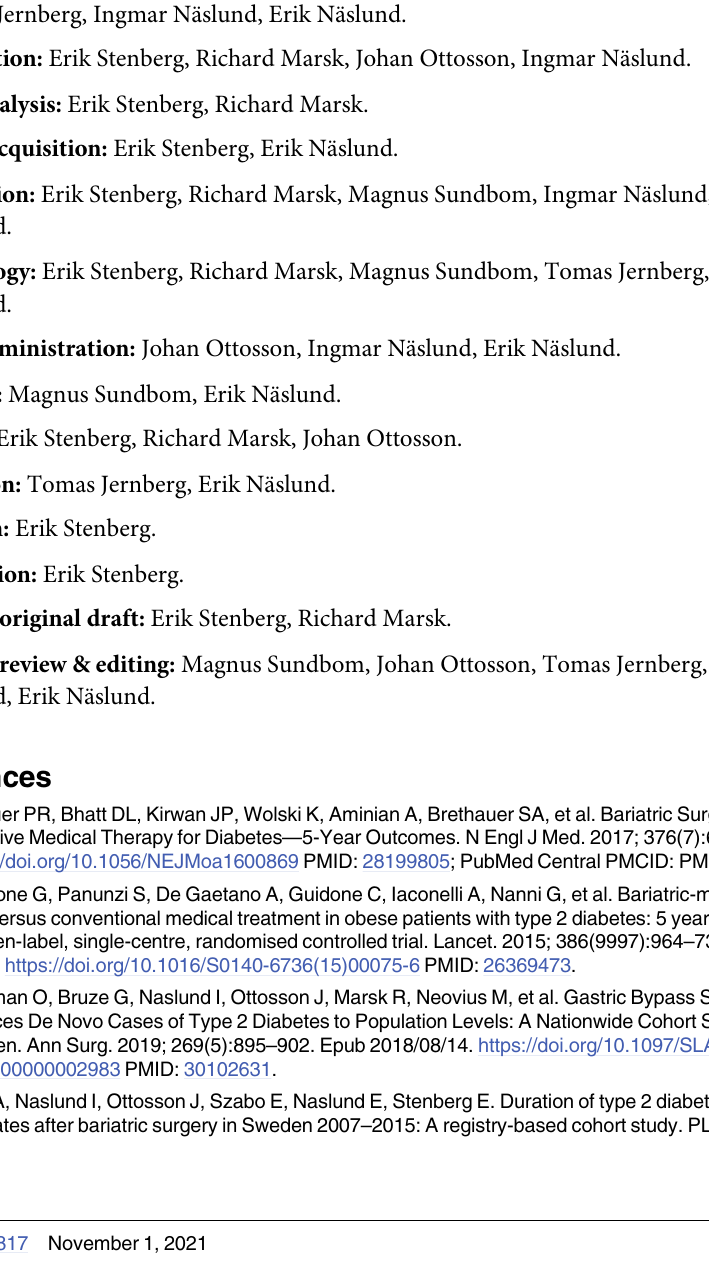
S4 Table. Multivariable Cox regression model for the occurrence of MACE up to 8 years after surgery. MACE, major adverse cardiovascular event. S5 Table. Multivariable Cox regression model for the occurrence of mortality up to 10 years after surgery. S1 Fig. Stacked histogram of numbers of antihypertensive drugs before and 2 years after